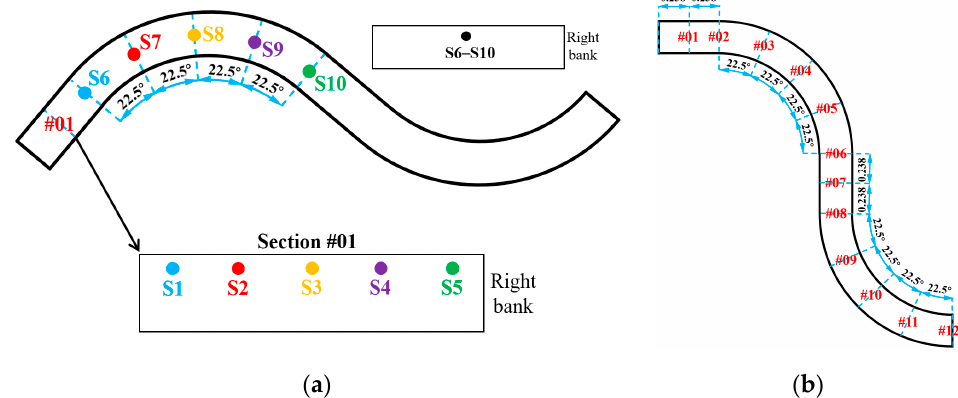
Figure 2. Information on the considered cases in numerical study: ( a ) the locations of point source in all scenarios; ( b ) typical cross-sections in the meander.